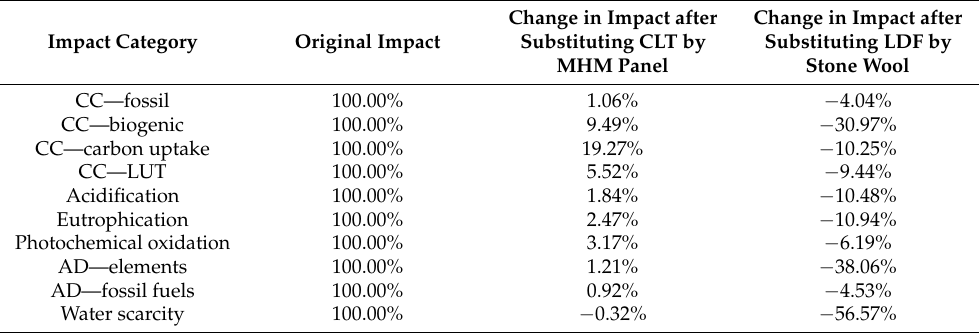
Table 6. Overall changes in the embodied impact of the construction after substituting the most relevant construction